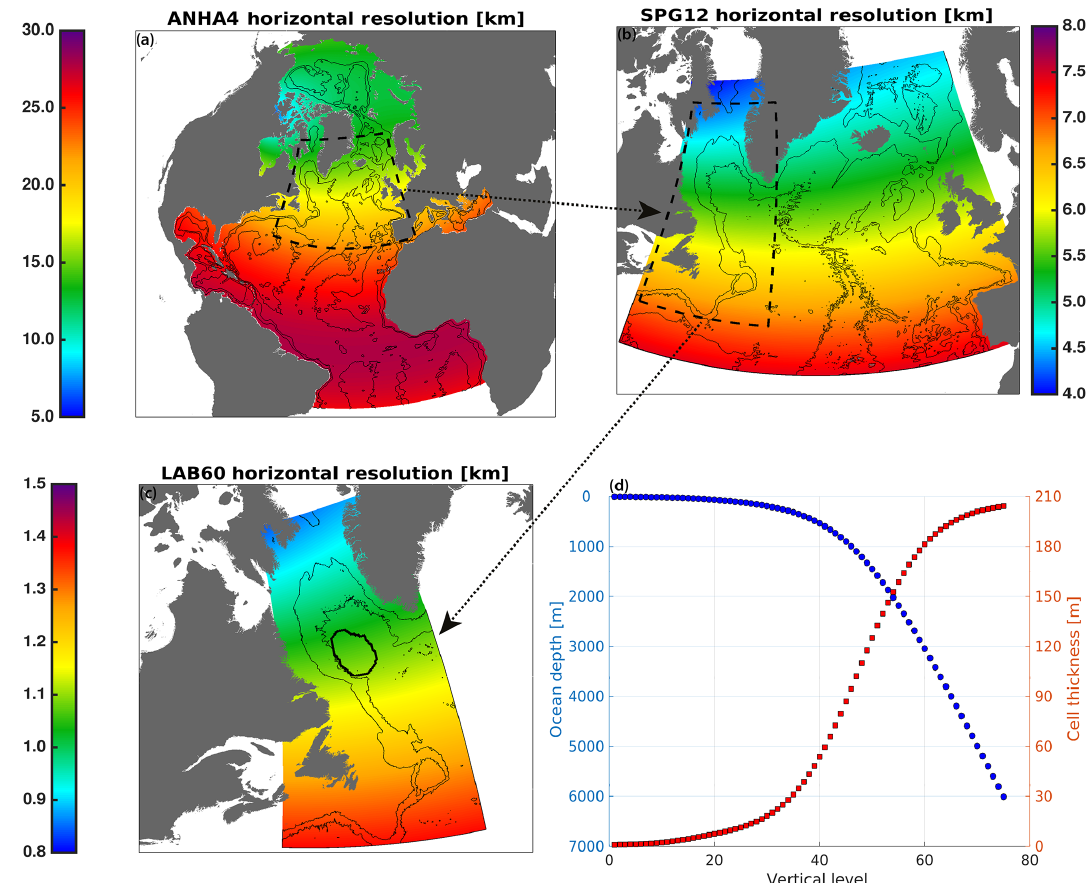
Figure 1. Domain setup for the (a) ANHA4 parent domain, (b) the SPG12 nest, and (c) the LAB60 nest. The horizontal grid resolution, in kilometers, is identified by color. All domains share identical vertical grid structure (d) . The thick black contour in panel (c) identifies a region of interest where calculations of LSW’s density, thickness, and mixed layer depth are determined. The 1000, 3000, and 5000m isobaths are shown via the thin black